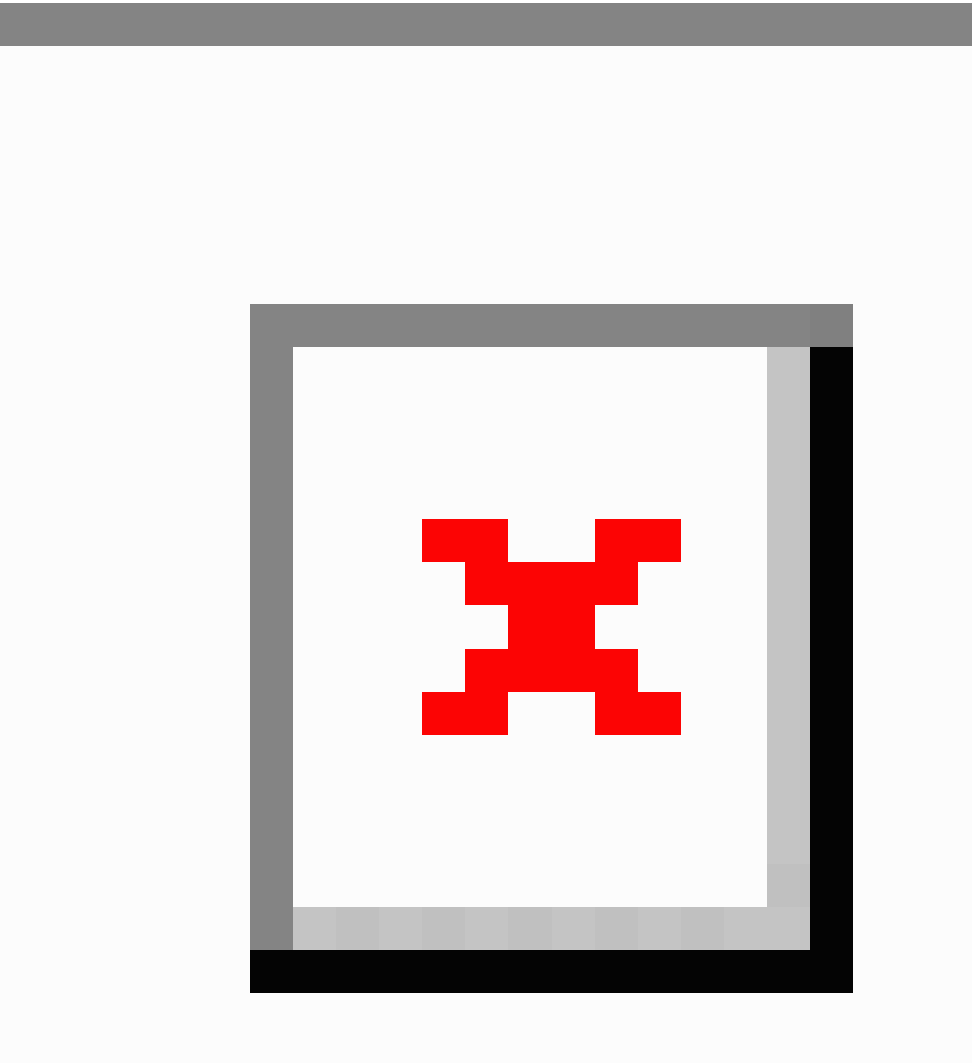
Figure 1. Physical activity and interest in mobile fitness apps with regard to the body mass index (BMI) class of the university staff surveyed. (Top) BMI and physical activity ( ≥ 3 days/week). (Bottom) BMI and the interest in mobile fitness apps to increase physical activity in less active individuals (<3 days/week). BMI is usually expressed in kilogram per square meter